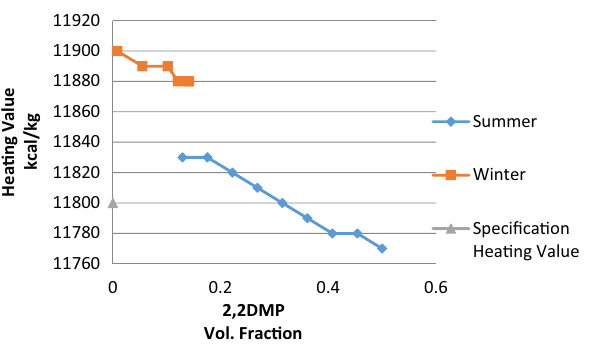
Fig. 14 Effect of adding 2,2DMP on LPG price